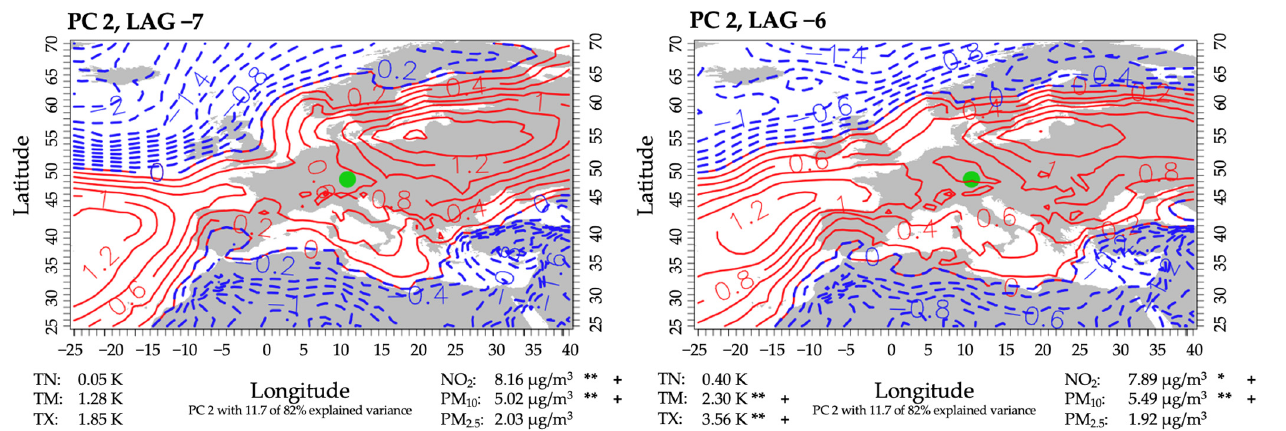
Figure 5. Same as Figure 4, but for PC 2. The level of significance is provided (**: 0.05; *: 0.1). The mean difference of all days of the same lag minus the mean of all non-high-mortality-related days, indicated by + or − . + indicates a higher anomaly mean on the corresponding lag days than on non-high-mortality-related days. − indicates a lower anomaly mean on the corresponding lag days than on non-high-mortality-related days.